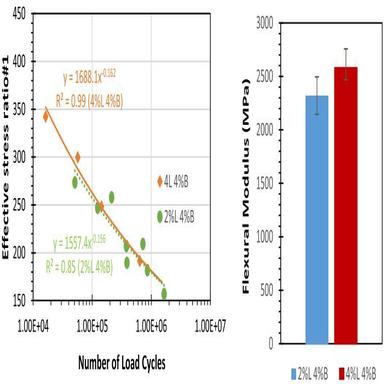
a.) Effect of lime content on FBS flexural fatigue life; b.) Effect of lime content on flexural modulus.